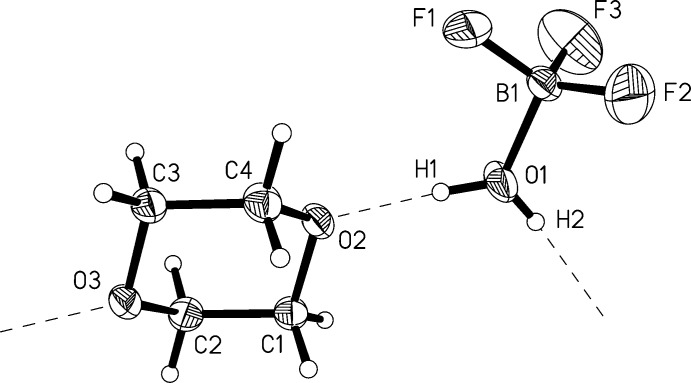
Diagram of the asymmetric unit of the crystal structure of com­pound 1, displaying the atom-labelling scheme. Anisotropic displacement ellipsoids are drawn at the 40% probability level and the radii of H atoms are chosen arbitrarily. The direction of hydrogen bonding is given by dashed lines.